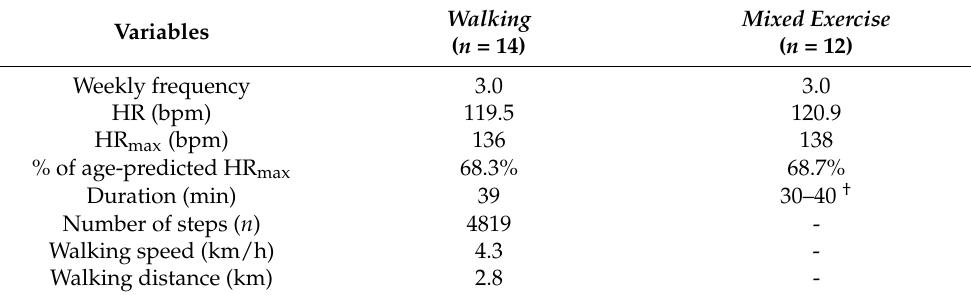
Table 5. Exercise program characteristics * for the Walking and Mixed Exercise arms.